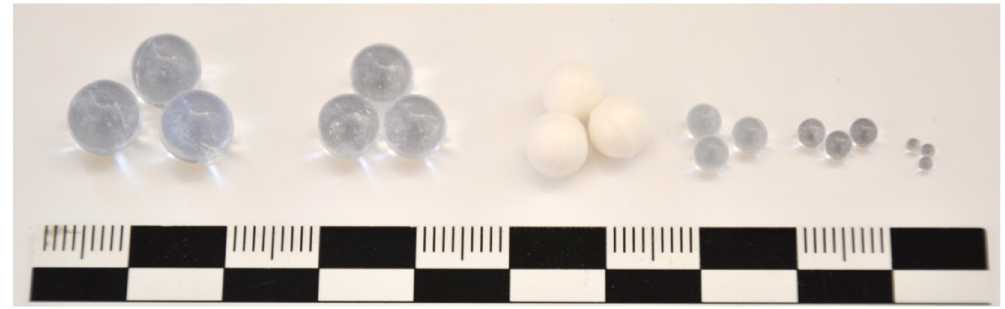
Figure 2. Glass balls (G) and corundum balls (C) sorted from left to right according to their diameter in mm (G8/G7/C7/G4/G3/G1.5) [27]. Table 1. Glass balls (G) and corundum balls (C), technical